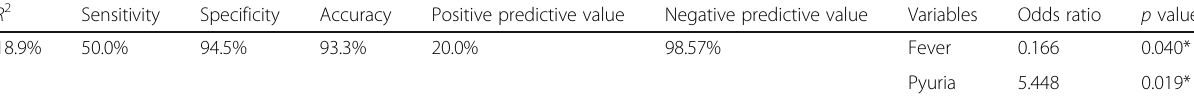
Table 7 Binomial logistic regression analysis model for prediction of UTI in neonates by fever and pyuria R 2